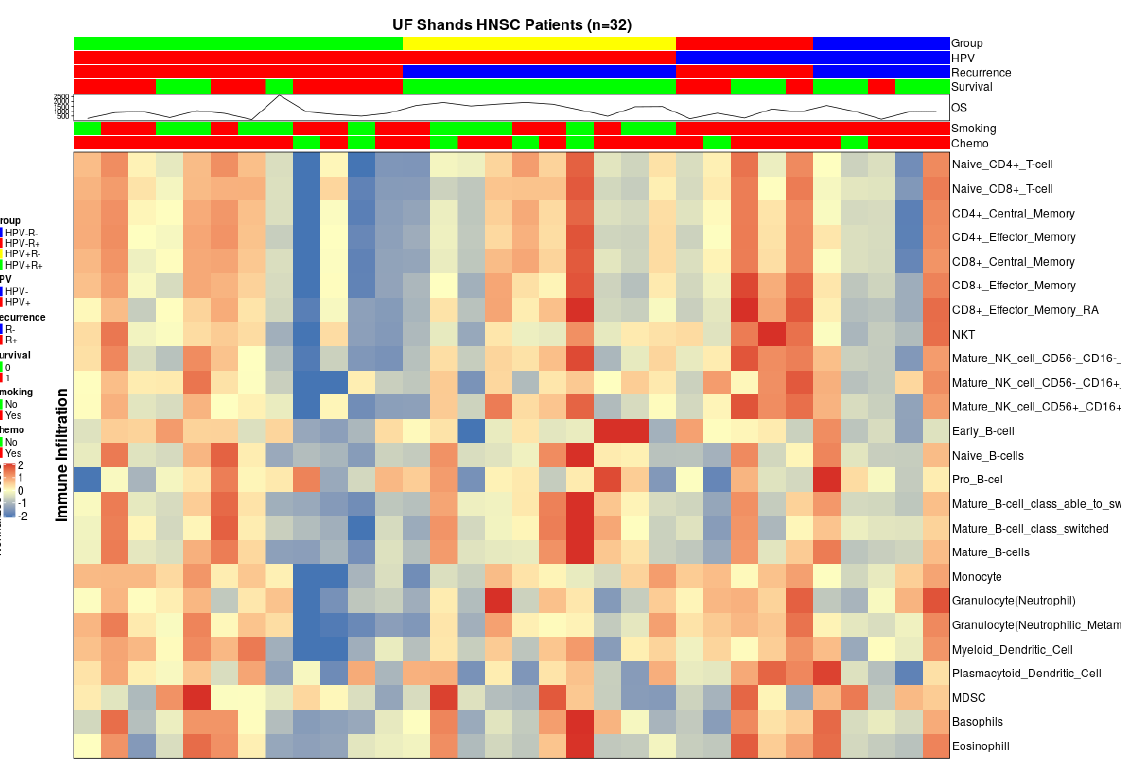
Figure 1. Enrichment of immune cells in oropharynx cancer patients based on HPV and recurrence status demonstrates increased suppressive monocyte/macrophage cell signatures. The heatmap demonstrates overall higher expression of myeloid cell expression pathways in HPV+R+ patients when compared to the other cohorts, specifically in the monocytic and T cell pathways. Suppressive monocyte and myeloid cell progenitor enrichment resulted in significant differences.